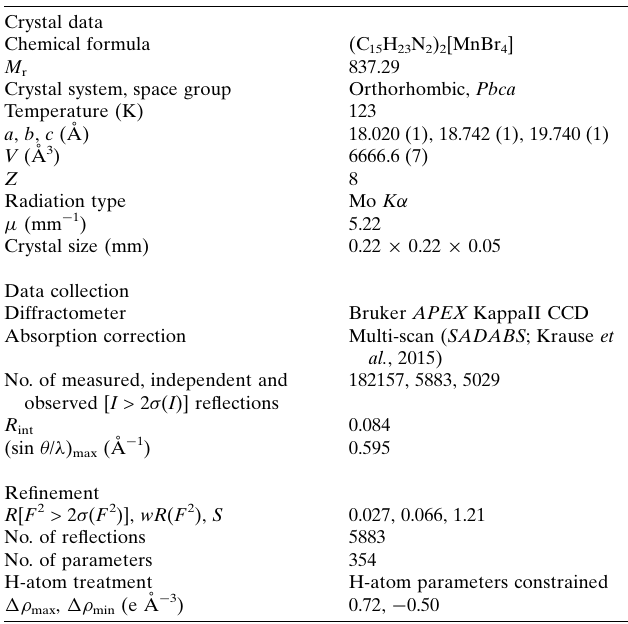
Crystal data Chemical formula